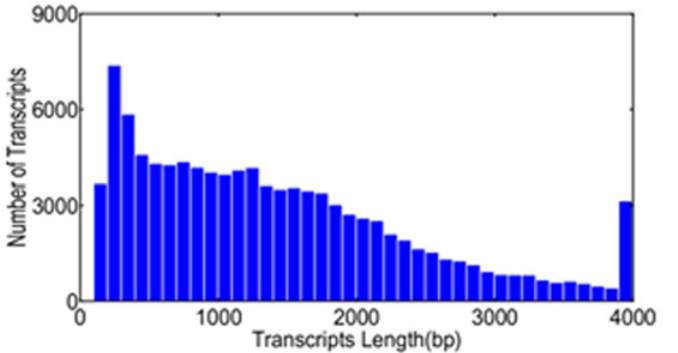
Fig 1. Length distribution of the assembled unigenes in the transcriptome.